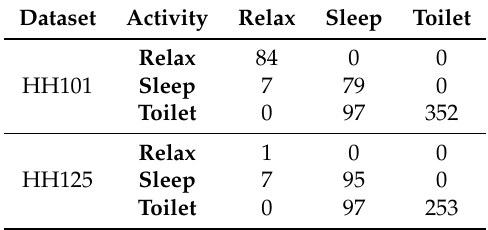
Table 6. Confusion matrix for zero-shot activity recognition—Scenario